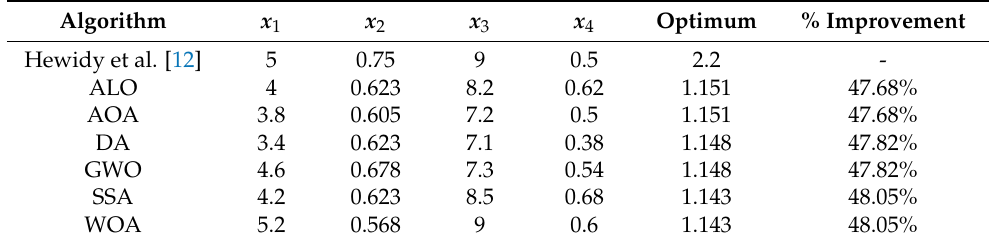
Table 5. Comparison of current results with solutions from the literature for SR optimization. Algorithm